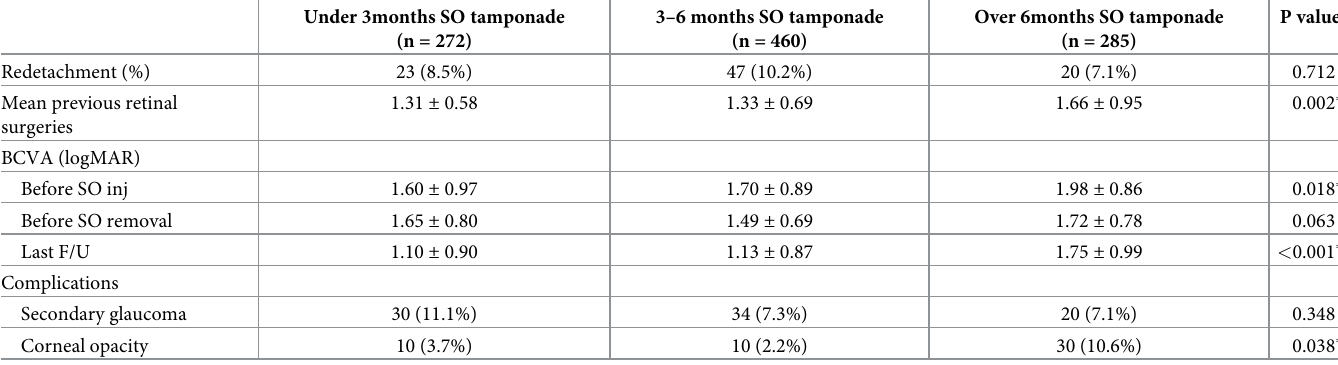
Table 4. Comparison of results according to silicone oil tamponade